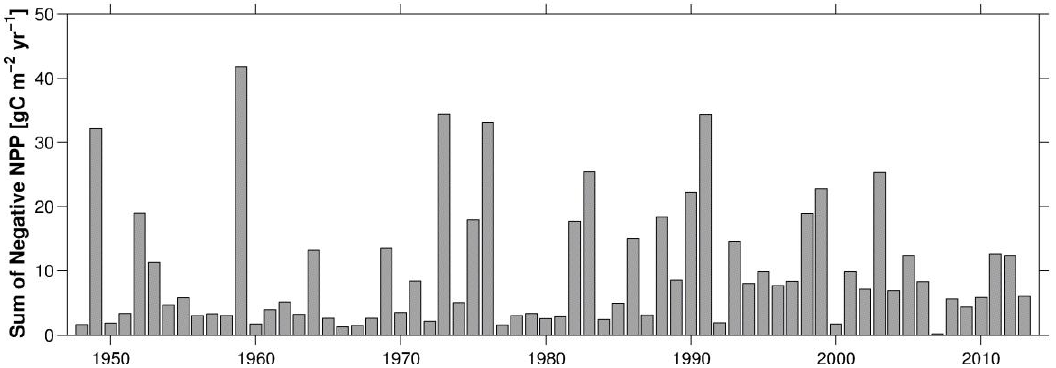
Figure 4. Time series of NPP (bold line) and VPD for deciduous forest in Trier. Phases of high VPD often correlate with negative NPP.